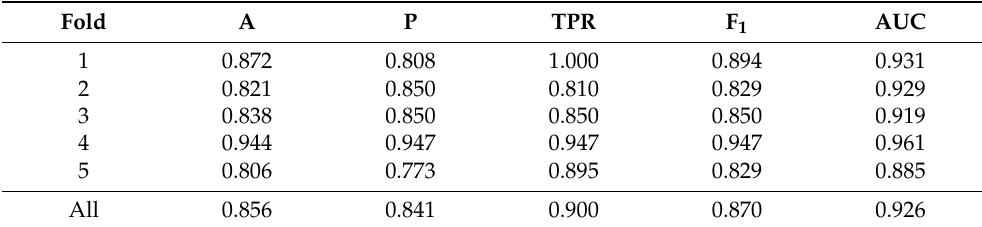
Table 3. Results for 3D ResNet.